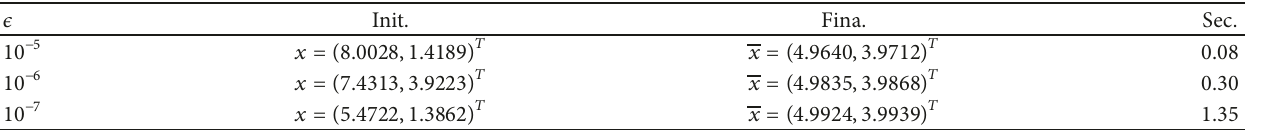
Table 2: The final value and the cpu time for different 𝜖 .